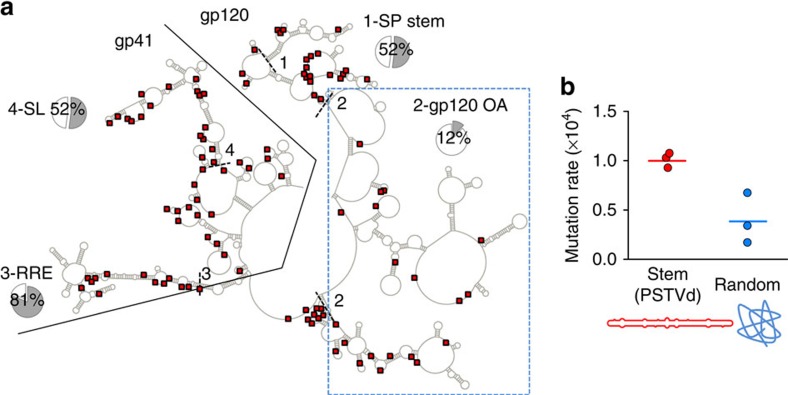
Effect of RNA structure on the HIV-1 mutation rate.(a) Mapping of the shuttle vector spontaneous mutations in the env RNA structure model. Nucleotide substitutions are represented with red squares. Regions encoding gp120 and gp41 are separated with a black line. Short dashed lines delimit the following regions in the structure: SP stem (1), region encoding the gp120 OA domains (2), Rev-responsive element (RRE, 3), and a multi stem-loop structure identified in gp41 (SL, 4). For each, the pie chart indicates the fraction of sites forming base pairs, considering only sites for which the pairing status has >90% chance of being conserved across HIV-1 subtypes. (b) In vitro mutation rate of the HIV-1 RT using a stem-like template RNA obtained from PSTVd (red) versus a randomized sequence (blue). Each dot represents an individual replicate and the horizontal bars the mean rate. A list of mutations and their location is provided in Supplementary Data 5 (PSTVd) and Supplementary Data 6 (randomized).